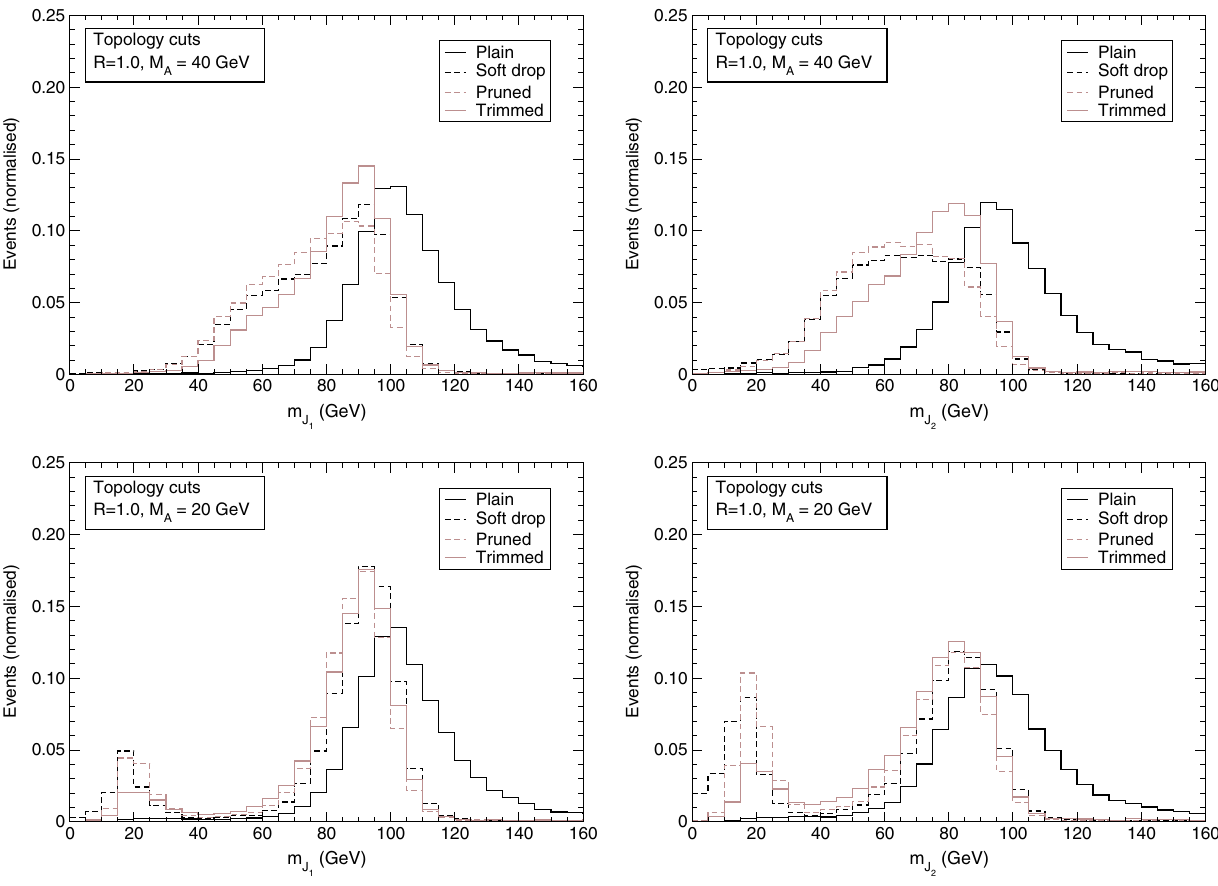
Fig. 18 Jet mass distributions for R → SS and different grooming algorithms, for jet radius R = 1 . 0 cannot be discarded with the simulations performed here on a final state with two